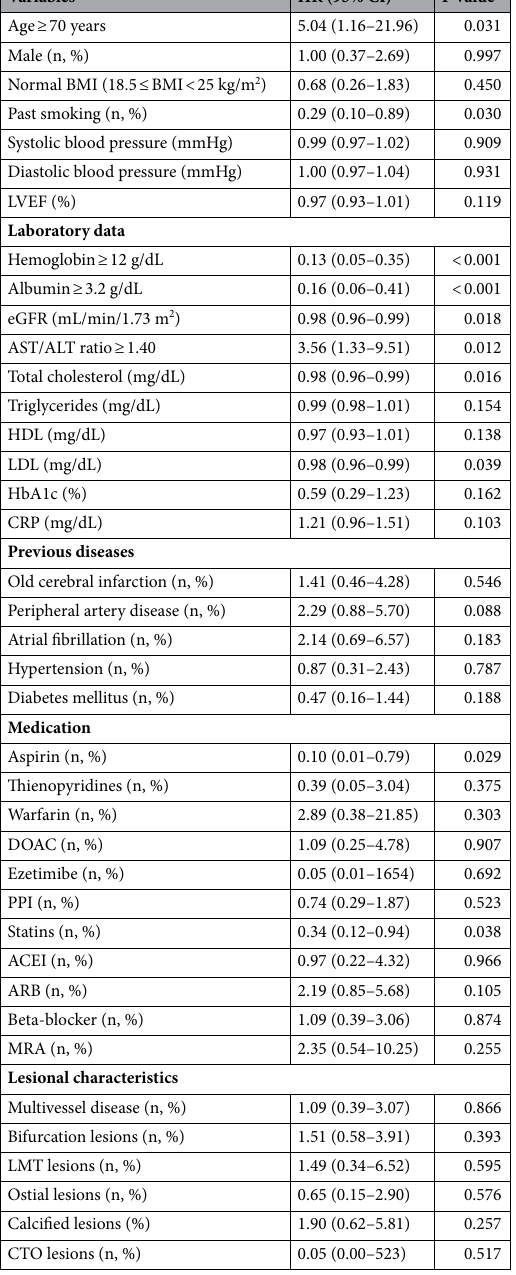
HDL high density lipoprotein, LDL low density lipoprotein, HbA1c hemoglobin A1c, CRP C-reactive protein, LVEF left ventricular ejection fraction, DOAC direct oral anticoagulants, PPI proton pump inhibitor, ACEI angiotensin-converting enzyme inhibitor, ARB angiotensin-receptor blocker, MRA mineralocorticoid receptor antagonist, MACE major adverse cardiac events, CTO chronic total occlusion, DES drug-eluting stent, LMT left main